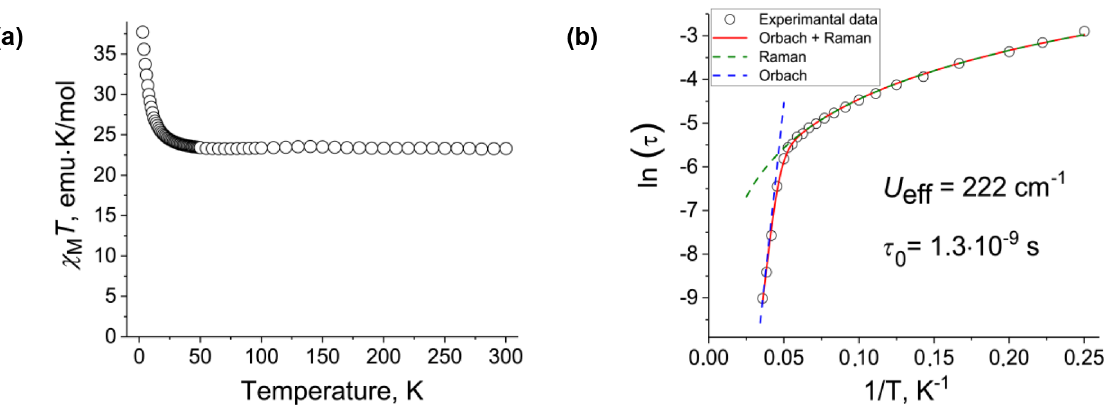
Figure 2. ( a ) Temperature dependence of χ M T for powdered sample of (Pc)Tb[(15C5) 4 Pc]Tb(Pc) 1 in the 300–1.9 K range. ( b ) The plot of ln( τ ) vs. 1/ T for powdered sample 1, which allows the U eff value to be determined.